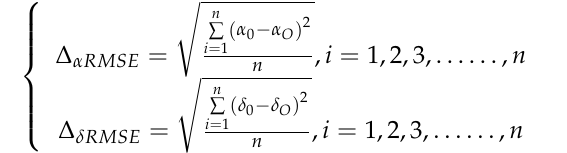
Figure 11. Errors of the RSO locations: ( a ) ascension direction; and ( b ) declination direction. The root‑mean‑square error (RMSE) of the results are calculated through Equation (24) to evaluate the effectiveness of the proposed STM method. The simulation results show that the RMSE of the ascension is 3.1556 ′′ , and that the RMSE of declination is 2.9295 ′′ .